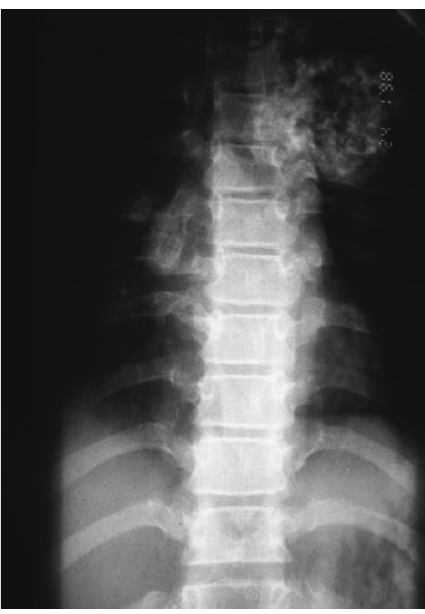
Figure 1: Conventional radiograph showed large cauliflower mass projecting along the anterolateral aspect of the spine.